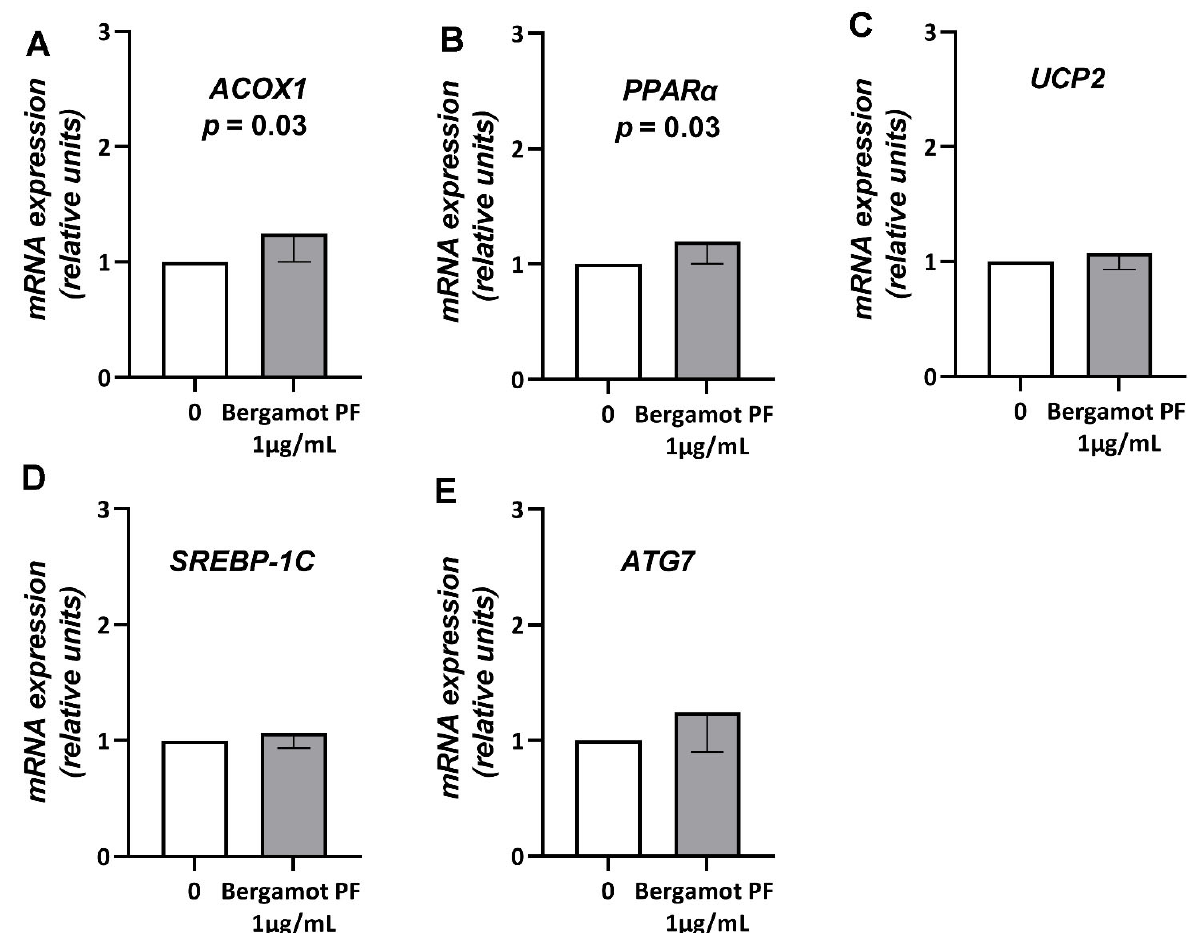
Figure 4. An increase in bergamot PF extract regulates ACOX1 and PPAR α mRNA expression levels in 3D spheroids. Here, HepG2 + LX2 cells were cultured as 3D spheroids for a total of 96 h. Then, 24 h after seeding, the media was supplemented with 1 µ g/mL bergamot PF extract for 72 h. Then, mRNA expression levels of ( A ) ACOX1 , ( B ) PPAR α , ( C ) UCP2 , ( D ) SREBP-1c , and ( E ) ATG7 were measured using real-time PCR. Data were analyzed using the 2ˆ- ∆∆ cq method and normalized to β - ACTIN . Data are represented as mean ± SD of three independent experiments. Statistical analysis was as follows: Student’s t ‐ test vs. 0, p = 0.03 and p = 0.03, respectively. Abbreviations are as follows: PF, polyphenol fraction; ACOX1 , peroxisomal acyl ‐ coenzyme A oxidase 1; PPAR α , peroxisome proliferator ‐ activated receptor ‐α ; UCP2 , mitochondrial uncoupling protein 2; SREBP ‐ 1c , sterol regulatory element ‐ binding protein; ATG7 , autophagy related 7; 3D, three dimensional; SD, standard deviation.